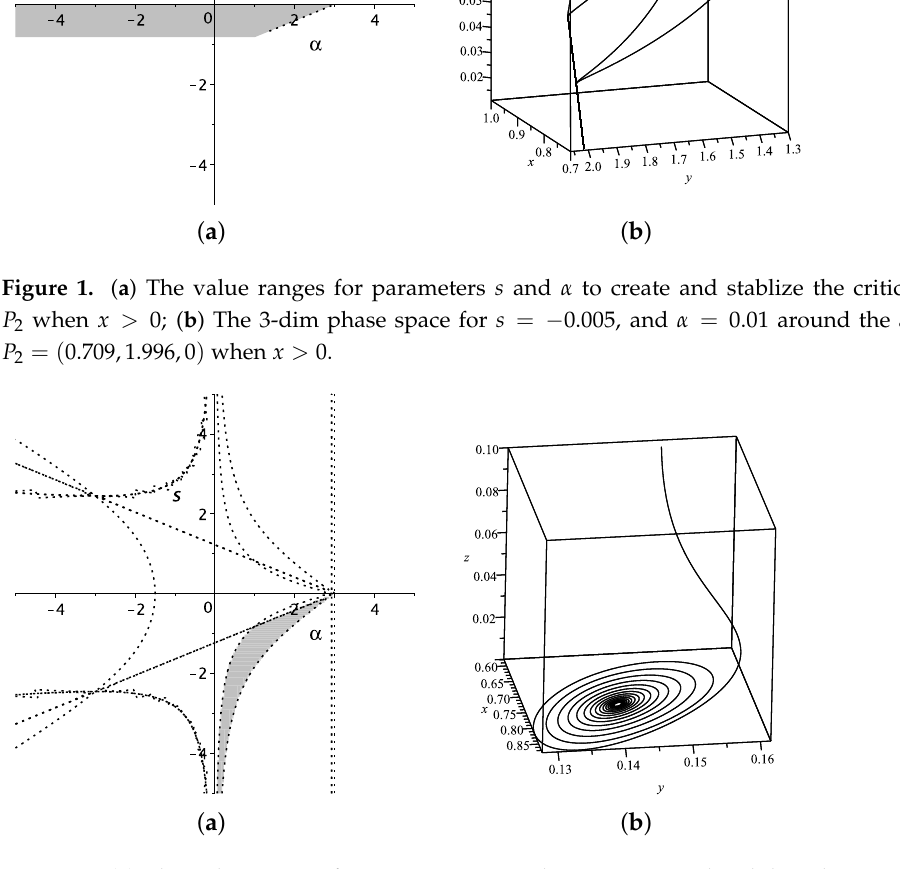
Figure 2. ( a ) The value ranges for parameters s and α to create and stabilize the critical point P 3 when x > 0; ( b ) The 3-dim phase space for s = − 16.5, and α = 0.015 around the attractor P 3 = ( 0.738,0.142,0 ) when x > 0.